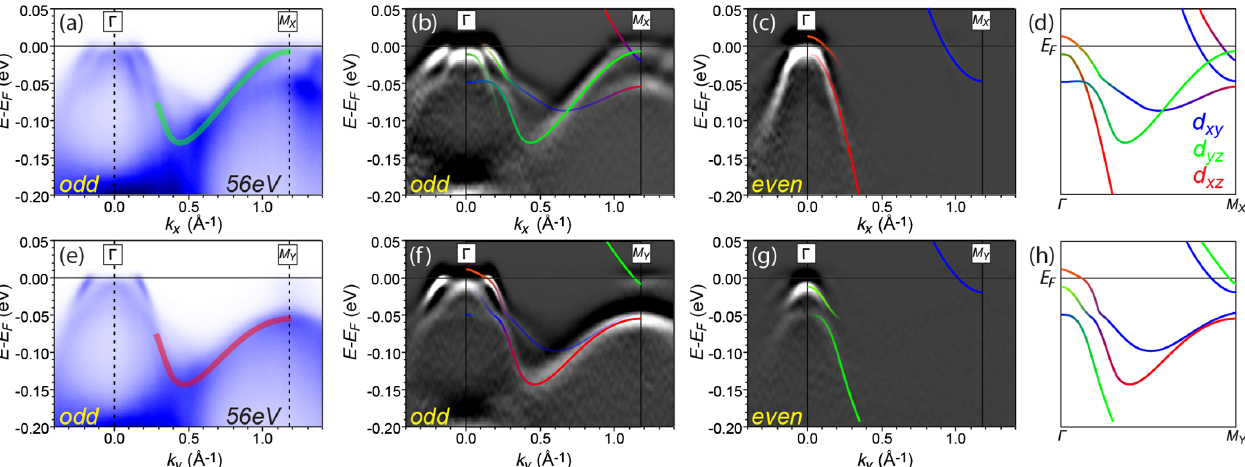
FIG. 2. Measured dispersions on detwinned FeSe at 56 eV (close to k z ¼ π ). (a) ARPES spectra measured along Γ − M X with odd polarization. (b),(c) Second energy derivatives of measured spectra along Γ − M X under odd and even polarization with respect to the cut direction, respectively. A schematic of bands of orbital symmetries with the allowed intensity under each polarization is overlaid. (d) The complete band schematic from both polarizations is summarized for Γ − M X . (e) – (h) A similar measurement as (a) – (d) but for the Γ − M Y